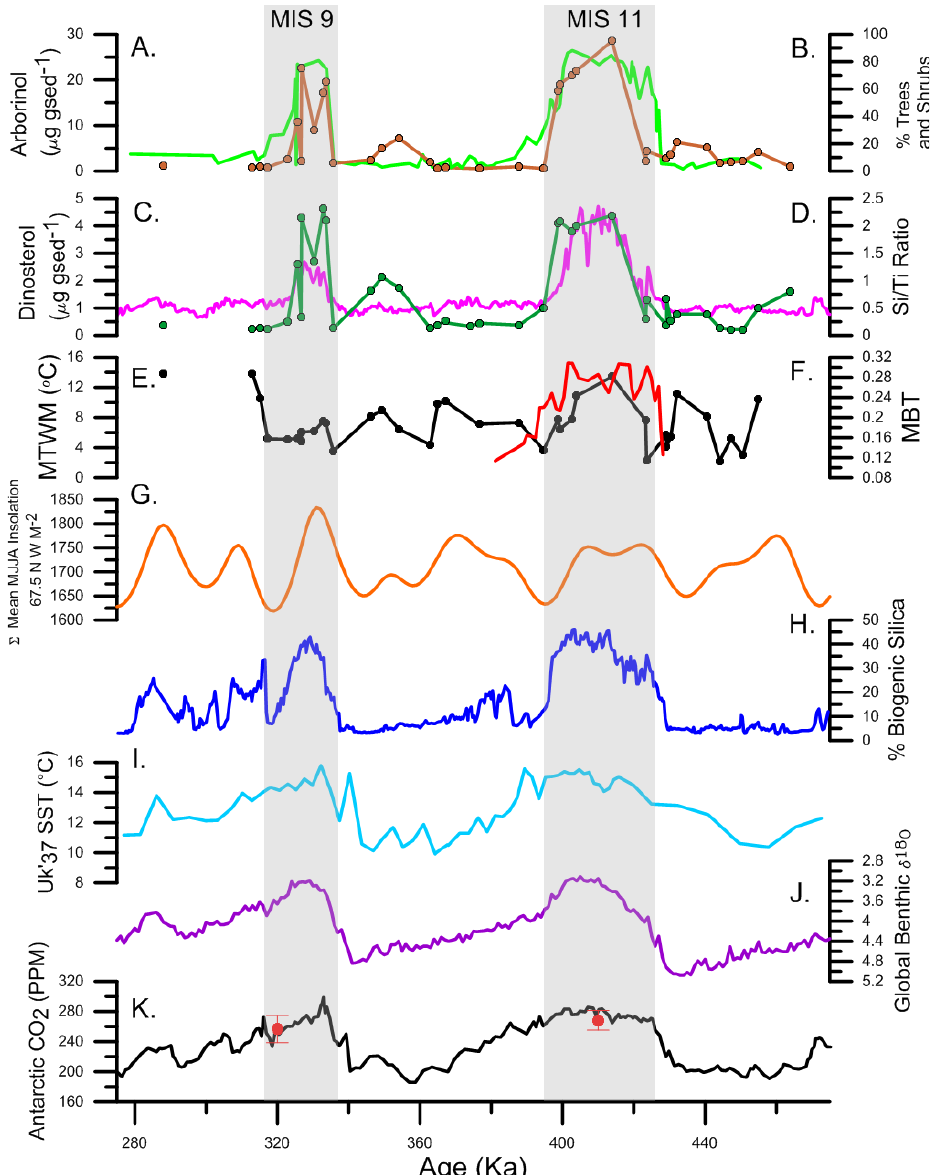
) (brown line and points) with (b) measured tree pollen counts (green Fig. 4. ( a through k ) (a) Measured arborinol concentrations (µgg − 1 sed ) (green points and line), compared with (d) Si/Ti line) (from Lozhkin and Anderson, 2013; Lozhkin et al., 2007b); (c) dinosterol (µgg − 1 sed ratio (red line) from Melles et al. (2012); (e) calculated mean temperature of the warmest month (Melles et al., 2012) with (f) calculated MBT ratio. (g) The sum of insolation from May, June, July and August (MJJA) from Laskar et al. (2004); (h) the Lake Baikal biogenic silica 0 ) from Lawrence et al. (2009); record (Prokopenko et al., 2007); (i) North Atlantic sea surface temperature (SST) record from alkenones (U K 37 (j) global benthic Foraminifera δ 18 O stack from Lisiecki and Raymo (2005); and (k) atmospheric CO 2 concentrations measured from the EPICA Antarctic Ice Core (EPICA Community Members, 2004), with red dots indicating average CO 2 concentrations for the MIS 9 and MIS 11 interglacial periods. Gray bars indicate the timing of MIS 9 and MIS 11 interglacial